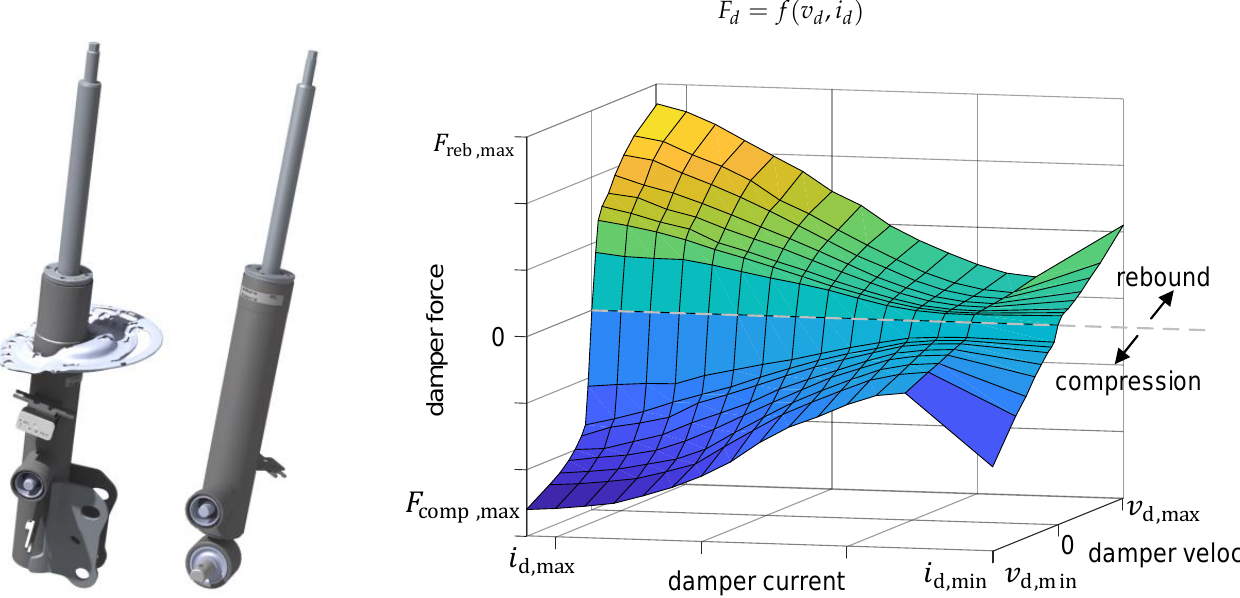
Figure 3. The remanufactured dampers for front and rear axle (left-hand side) and the two- dimensional characteristic map of AFM’s